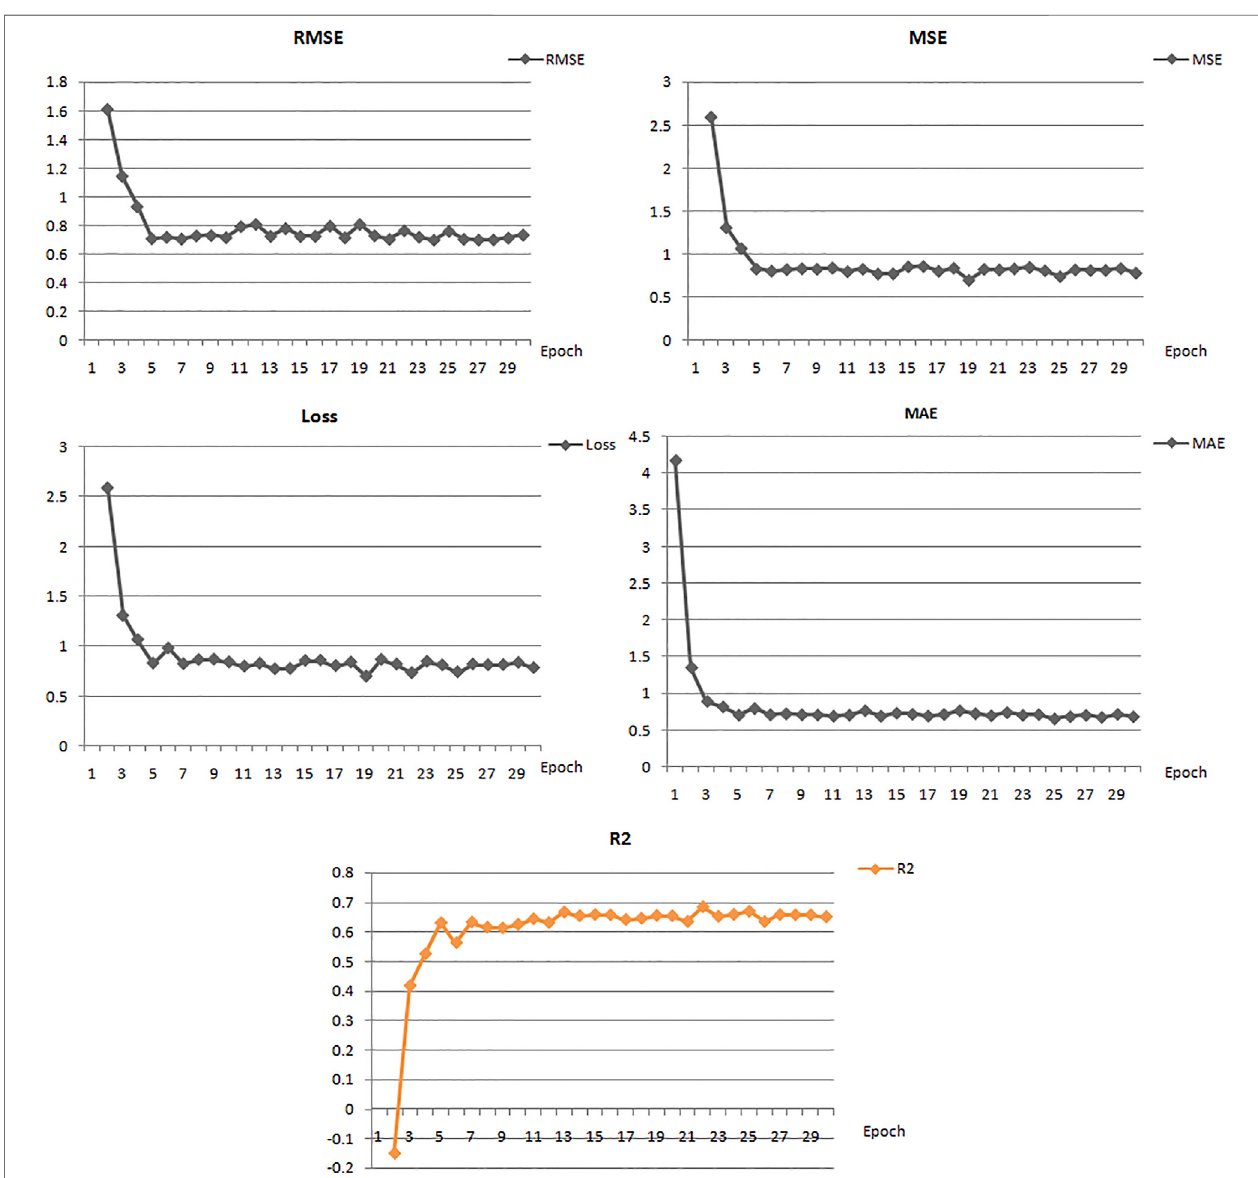
FIGURE 2 | Performance of the best deep learning regression model for MMP-9